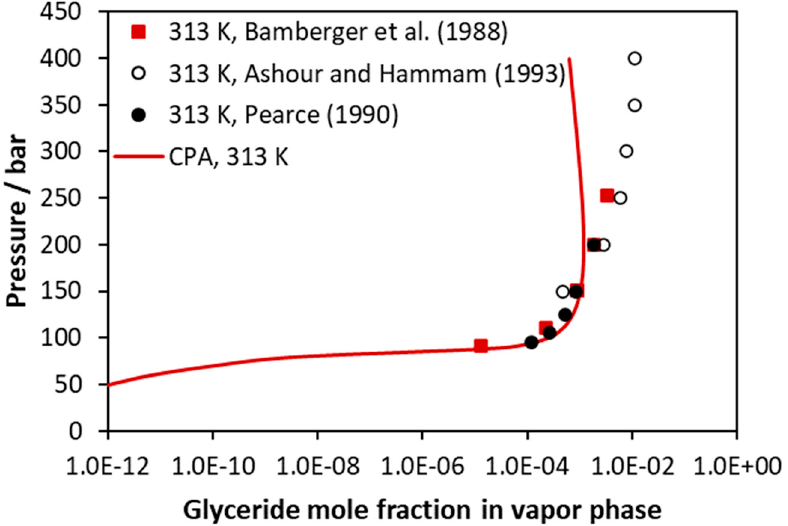
Figure 6. CO 2 –trilaurin VLE at 313 K (vapor phase compositions). Experimental data [46,48,49] and CPA correlations using the binary interaction parameter of Table 5.